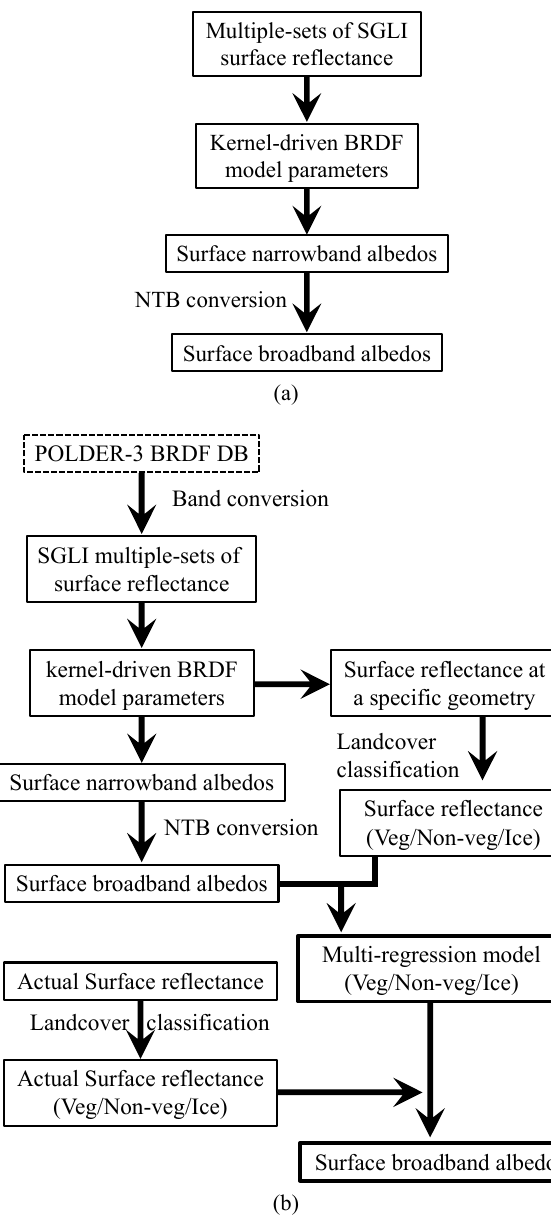
Figure 1. Methods for estimating terrestrial albedo: (a) using BRDF model; (b) using multi-regression